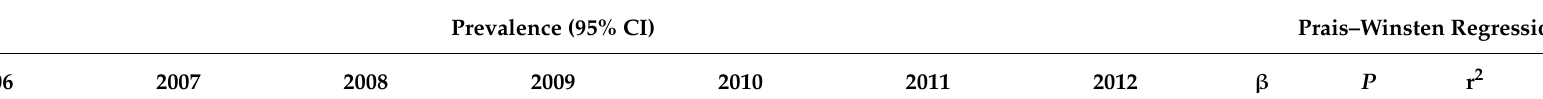
Table 4. Prevalence of abusive consumption of alcohol by adults, stratified by age group and regions of Brazil between 2006 and